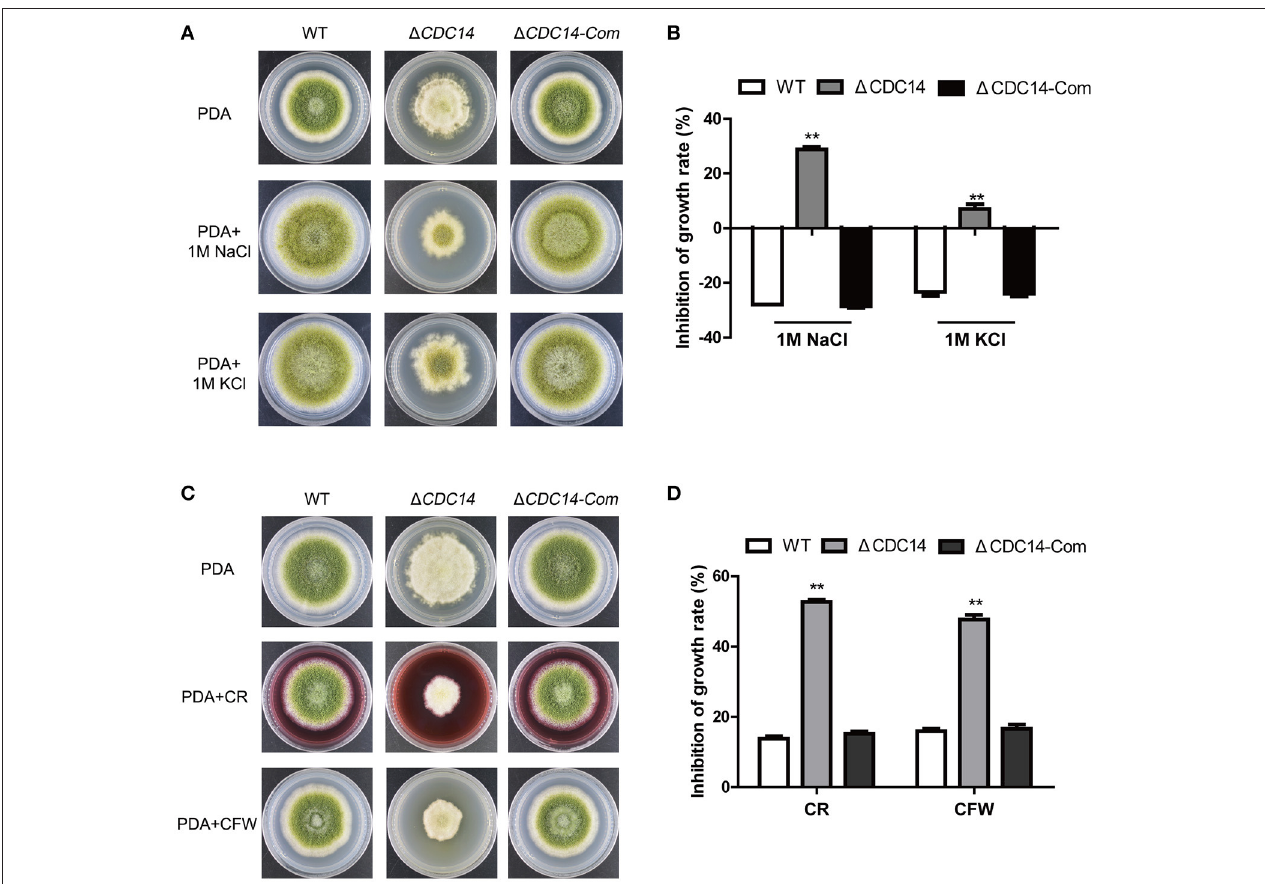
FIGURE 7 | The AflCDC14 is involved in response to hyperosmotic and cell wall integrity stresses. (A) Colonies of WT, 1 CDC14 and 1 CDC14- Com strains on PDA media with 1M NaCl and 1M KCl for 4 days. (B) Growth inhibition of each strain under hyperosmotic stress. [inhibition of growth rate = (the diameter of untreated strain- the diameter of treated strain)/(the diameter of untreated strain) × 100%]. (C) Morphology of different strains were grown on PDA media supplemented with 200 µ g/mL CFW and 200 µ g/mL CR for 5 days. (D) The inhibition growth rate of WT, 1 CDC14 and 1 CDC14- Com strains under cell wall integrity stress (** p ≤